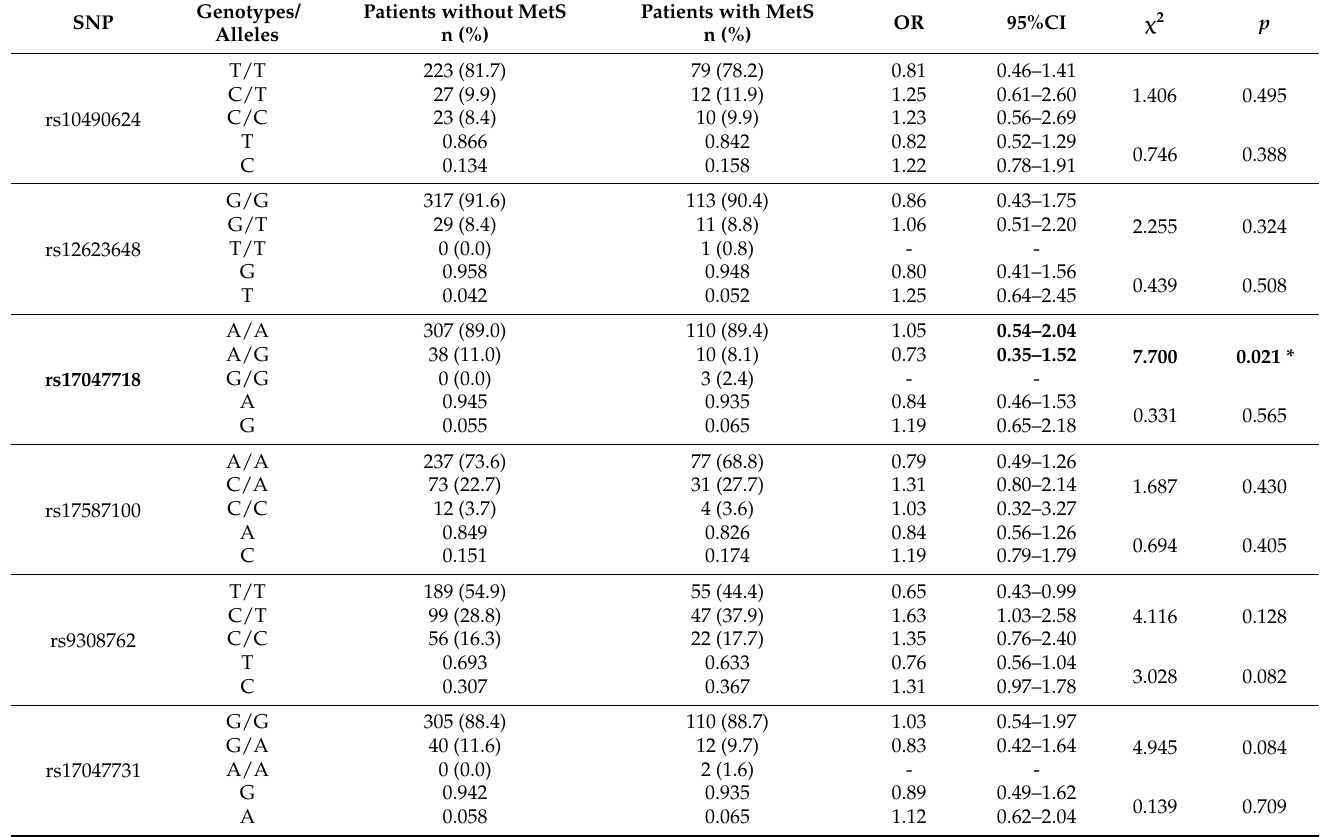
Table 3. Distribution of alleles and genotypes of INSIG2 polymorphisms in groups of